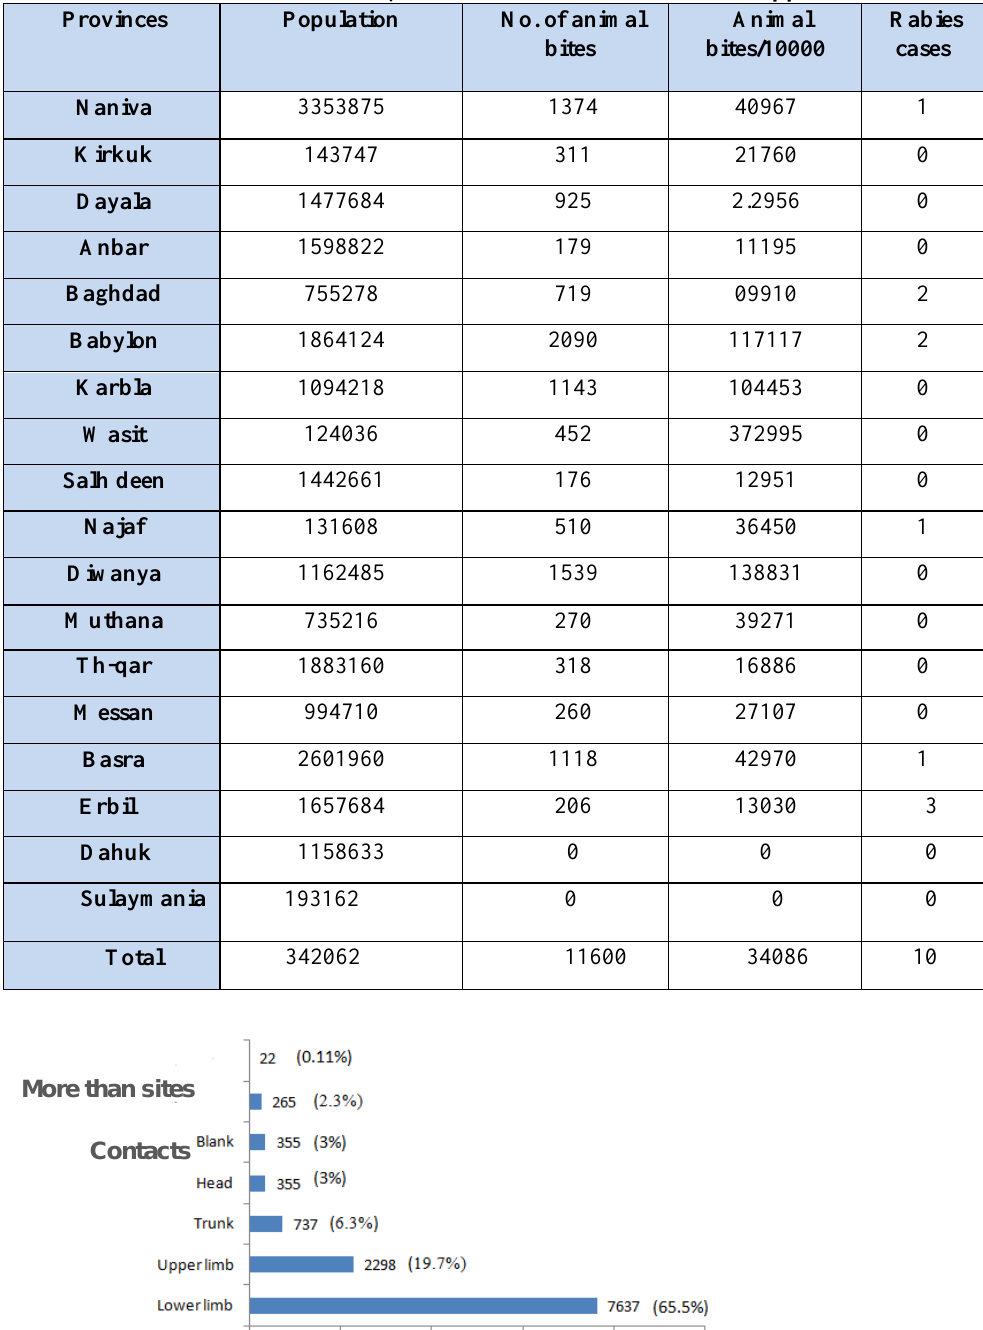
Graph (1): distribution of animal bites by governorates Iraq in 2012 Table (3): Animal bites, Rabies cases distribution in Iraq provinces 2012